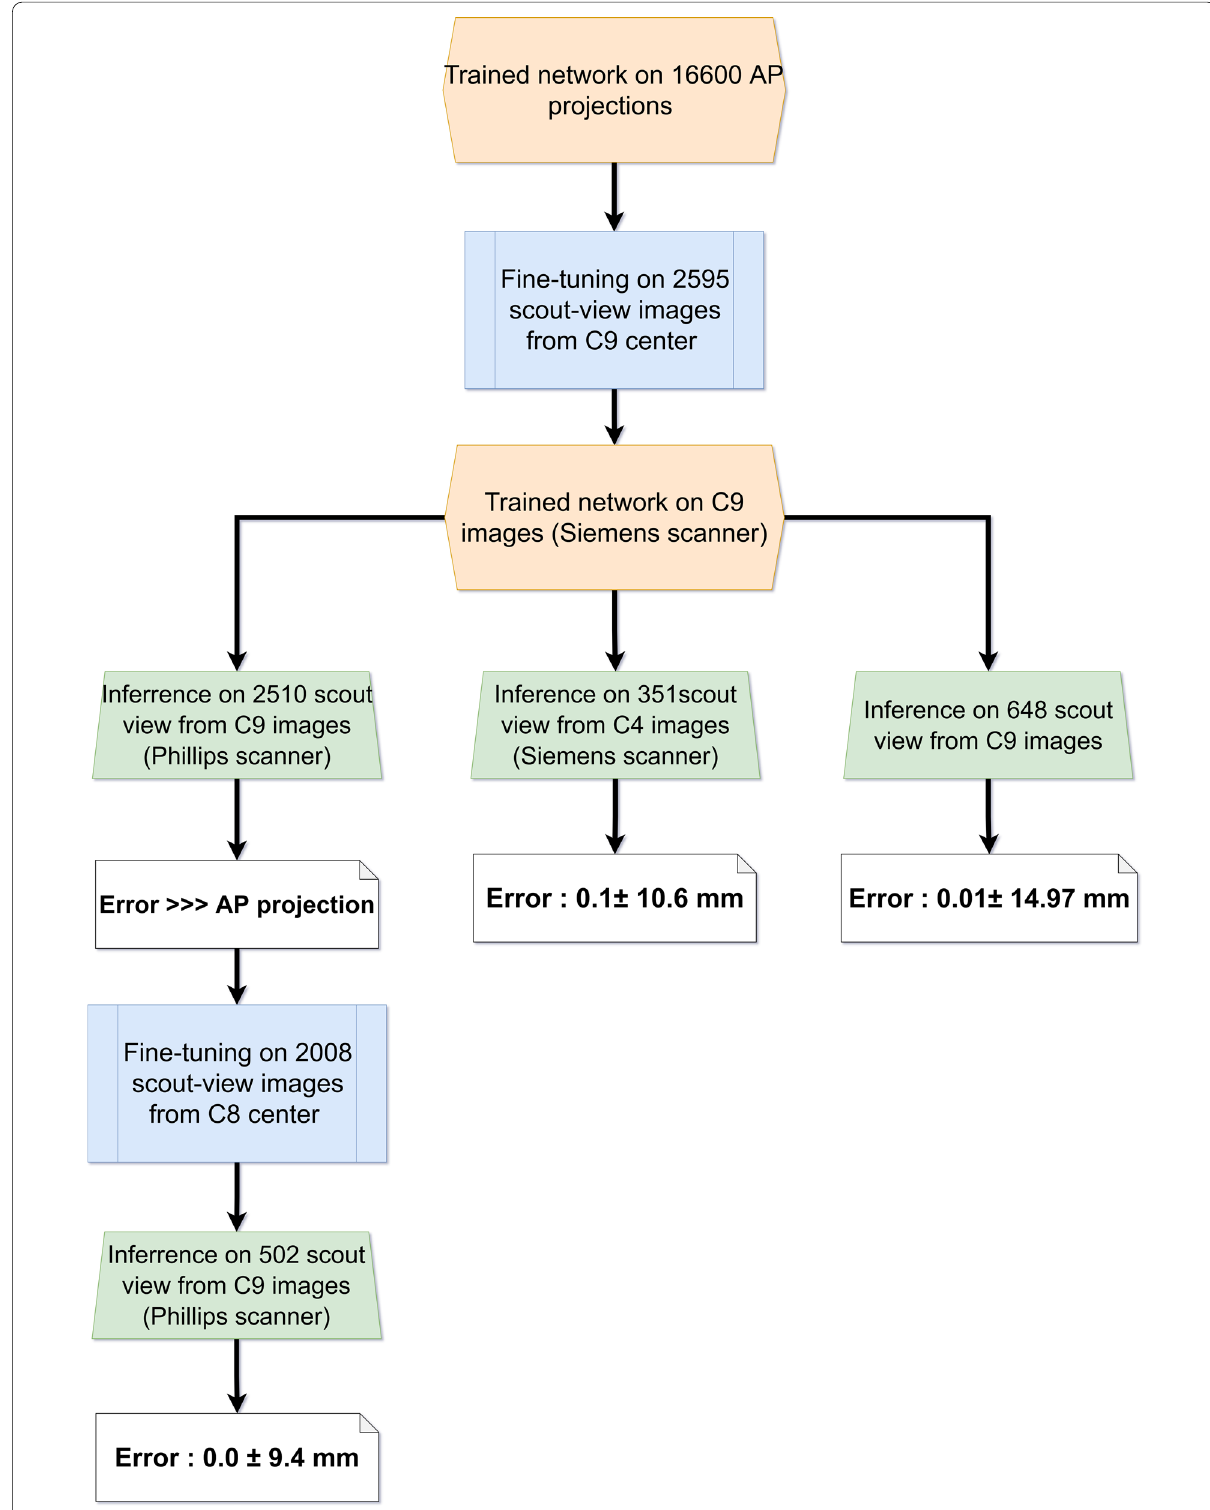
Fig. 2 Flowchart for analysis of scout view images included in this study after fine tuning on C9 images and testing the network on two other datasets of C4 and